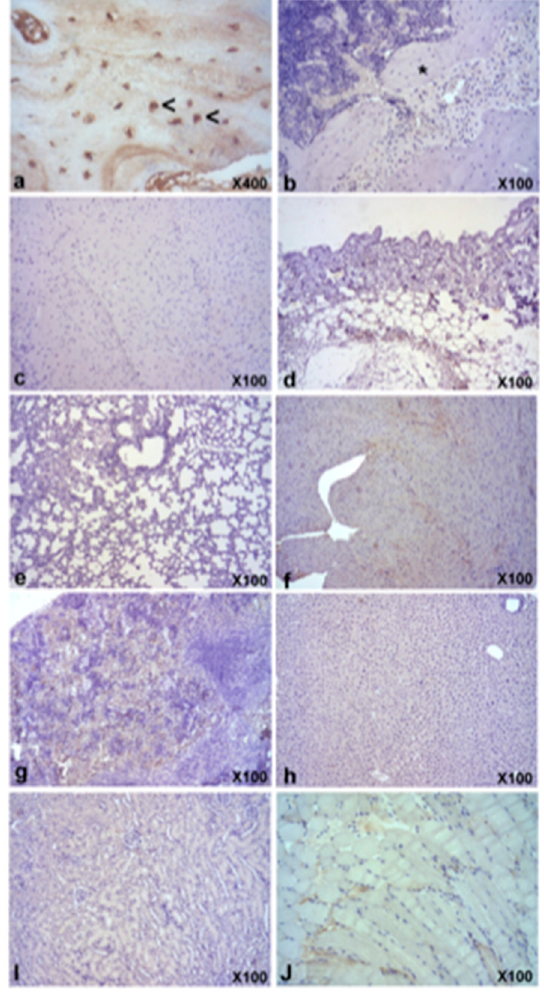
Figure 6. Representative images of expression of human osteocalcin in human bone (positive control, a ); and in mouse bone ( b ); brain ( c ); skin ( d ); lung ( e ); heart ( f ); spleen ( g ); liver ( h ); kidney ( I ) and skeletal muscle ( j ). While there is a strong positive expression of osteocalcin in lacunae in human control bone ( a , head arrows), no positive reaction was observed neither in bone ( b ), nor other tissues ( c – j ) in the mouse. ABC anti-human osteocalcin stain. Magnifications: 100 × ( a , b , e – j ).